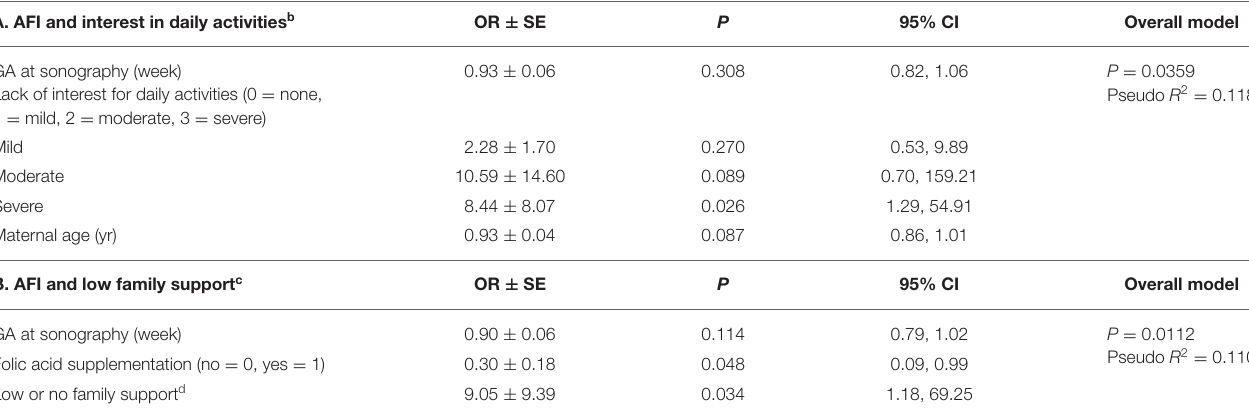
TABLE 7 | Multiple ordered logistic regression models for amniotic fluid index for elements of (A) the adapted conflict-related stress questionnaire and (B) the Colombian biopsychosocial risk assessment a